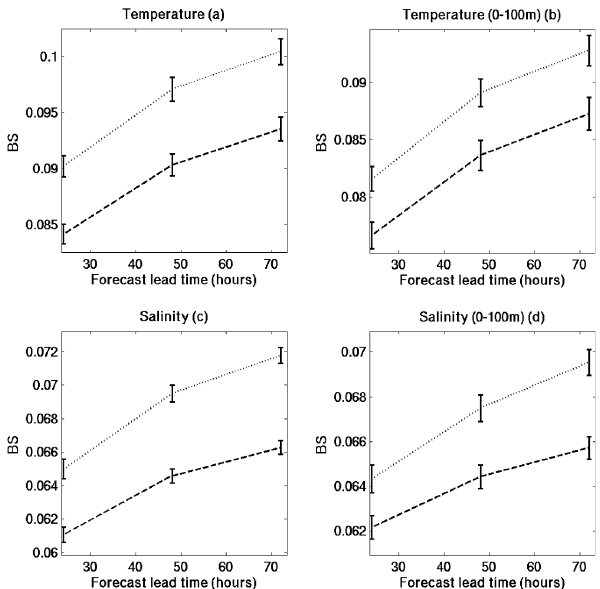
Fig. 9. Brier scores of temperature (top panel) and salinity (bottom panel) for ensembles r (dotted) and q (dashed) as functions of lead time. All BS values are averaged over the 109 days from 1 June to 17 September 2012, and averaged over the full observation space (left panel), and the layer between 0 and 100m (right panel). Error bars based on the standard error indicate the confidence